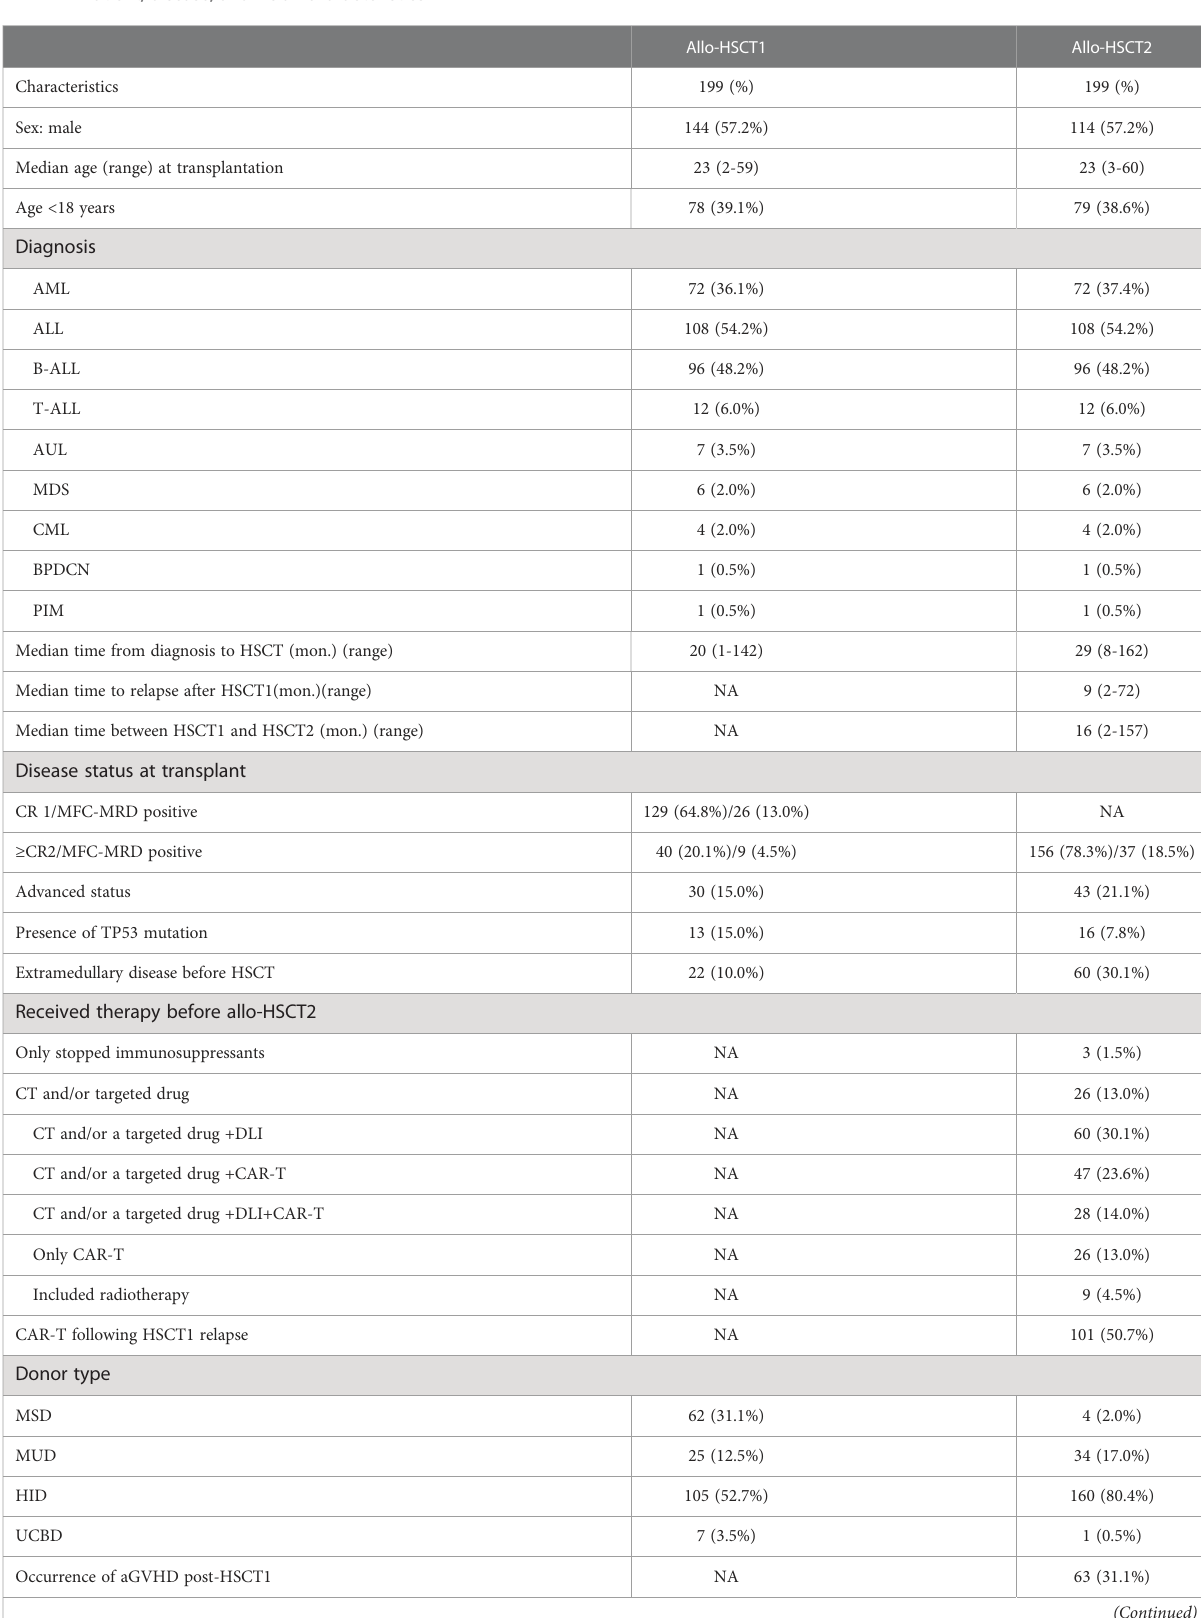
TABLE 1 Patient, disease, and HSCT